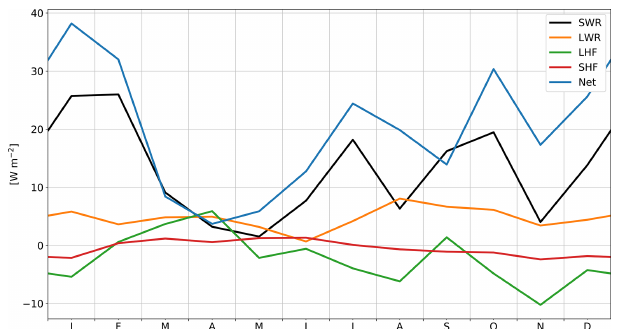
Figure A3. Climatology of the mean difference between the satel- lite and reanalysis data and the in situ measurements at the PIRATA- SEE mooring. For the shortwave (SWR) and longwave radiation (LWR) the TropFlux dataset is used, and for latent (LHF) and sen- sible heat flux (SHF) the MERRA2 dataset is used. The net surface heat flux (Net) is the mean difference of the sum of all fluxes be- tween the satellite and reanalysis data and the in situ